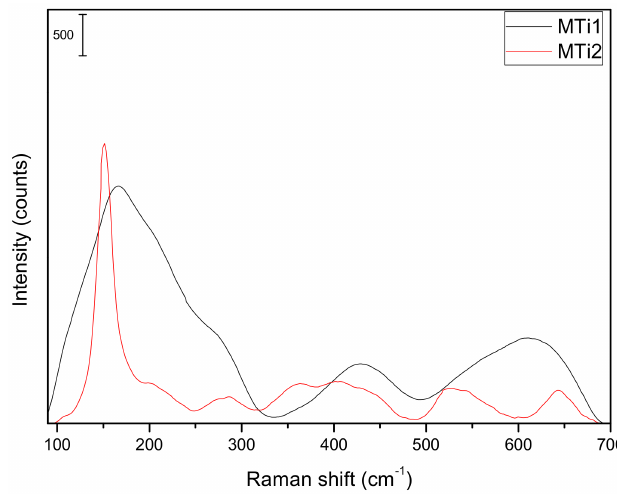
Figure 2. Raman spectra of samples MTi1 and